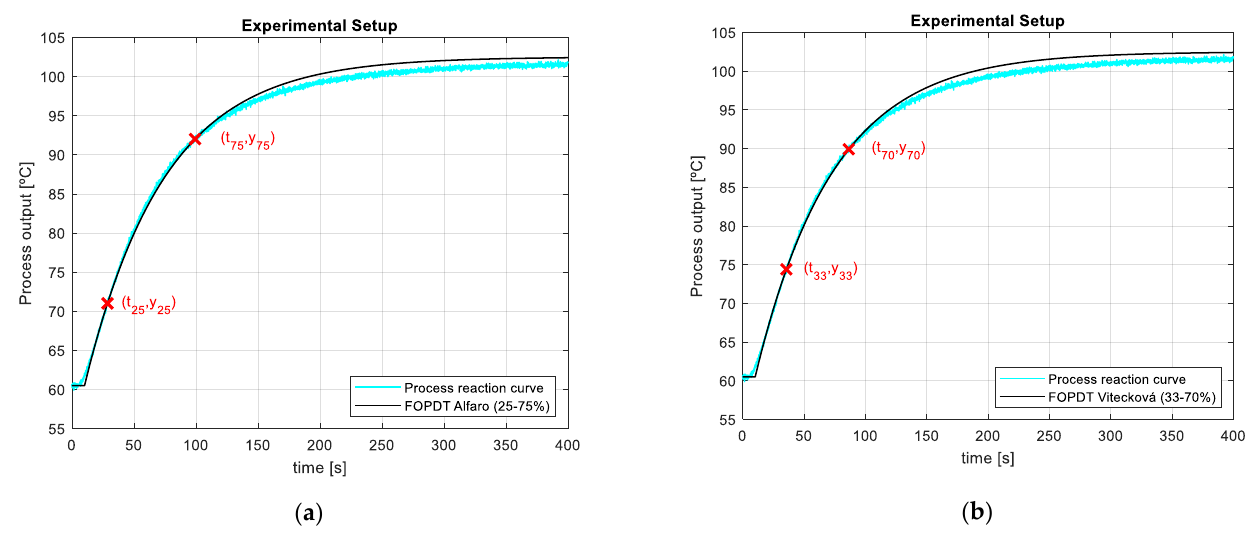
Figure 30. FOPDT model step response using two-point identification methods for the experimental setup in a certain operating point and process reaction curve: ( a ) Method proposed by Alfaro in [11] with symmetrical set of points (25 – 75%); ( b ) Method proposed by Vitecková in [14] with asymmetrical set of points (33 – 70%).